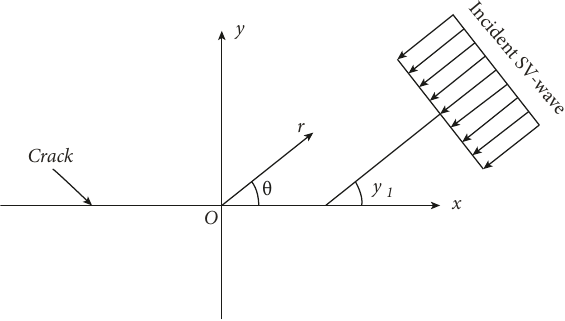
Figure 1: Interaction between SV-wave and